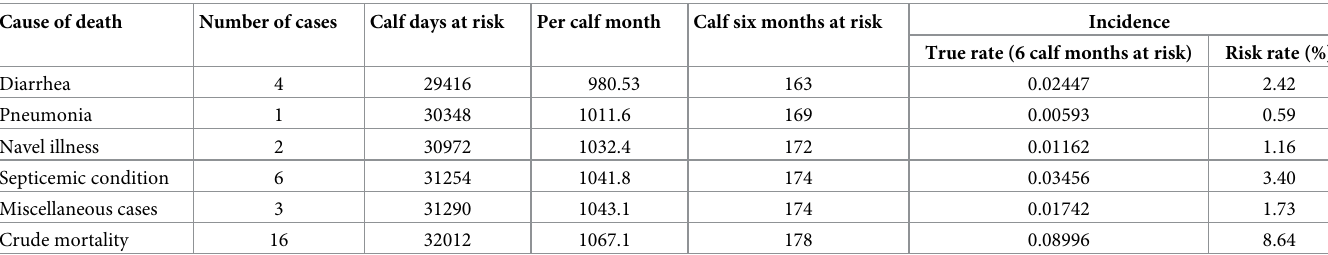
Table 5. The mortality of calf associated with different